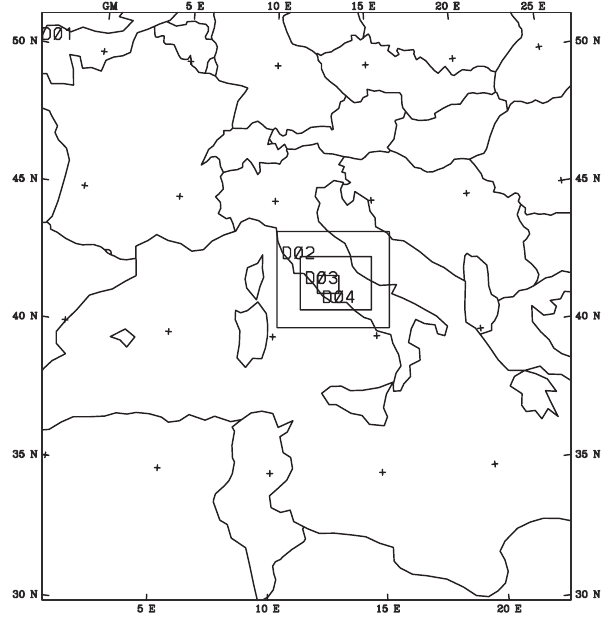
Fig. 1. WRF domains configuration. Domain D1 has resolution of 21.2km; D2 has resolution of 7.1km; D3 has resolution of 2.4km; D4 has resolution of